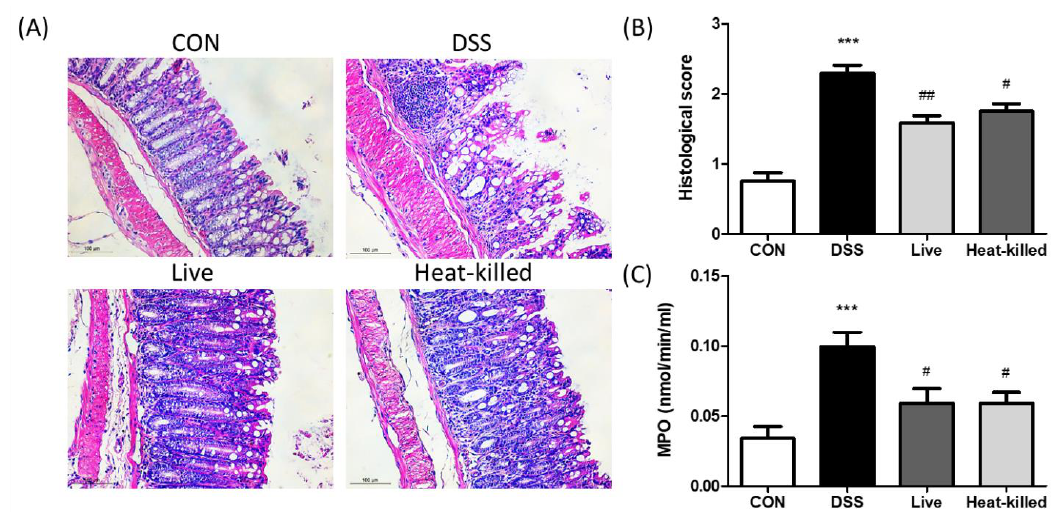
Figure 3. Hematoxylin – eosin-stained colon sections ( A ), histological score ( B ), and myeloperoxidase (MPO) activity of colon tissues ( C ) in DSS-induced colitis mice. Data are presented as mean ± SD. *** p < 0.001 versus the CON group, and # p < 0.05 and ## p < 0.01 versus the DSS group.